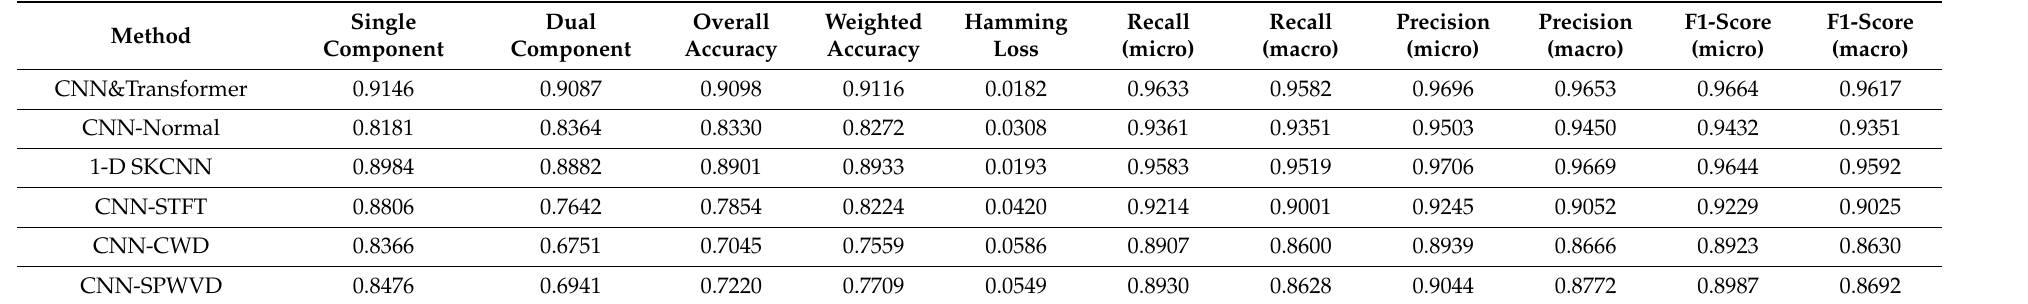
Table 5. The statistical results including average accuracy, Hamming loss, recall, precision and F1-score in macro level and micro level of the mentioned